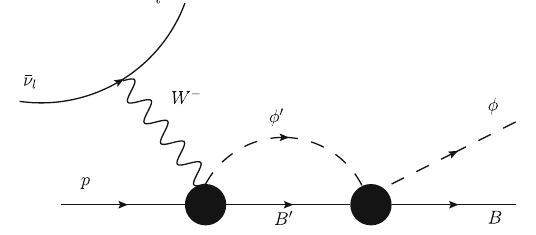
Fig. 17 Feynman diagram for the process ¯ ν l p → l + φ B